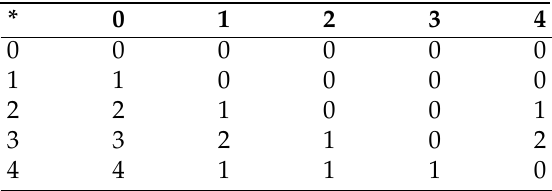
Table 1. Cayley table for the binary operation “ ∗ ”.